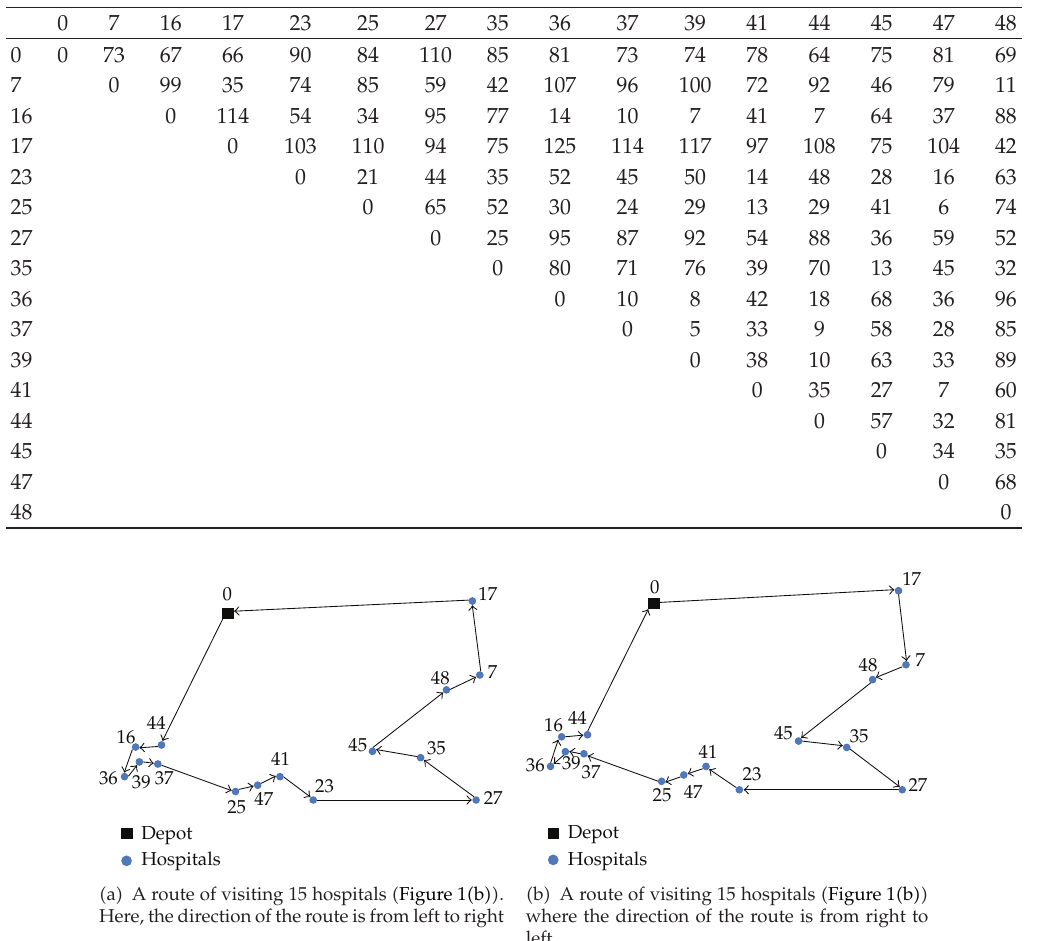
Figure 2: Two permutations of visiting hospitals of Figure 1 (cid:6) b (cid:7) . Note that the permutation presented in (cid:6) b (cid:7) has a worse objective function than the one in (cid:6) a (cid:7) .